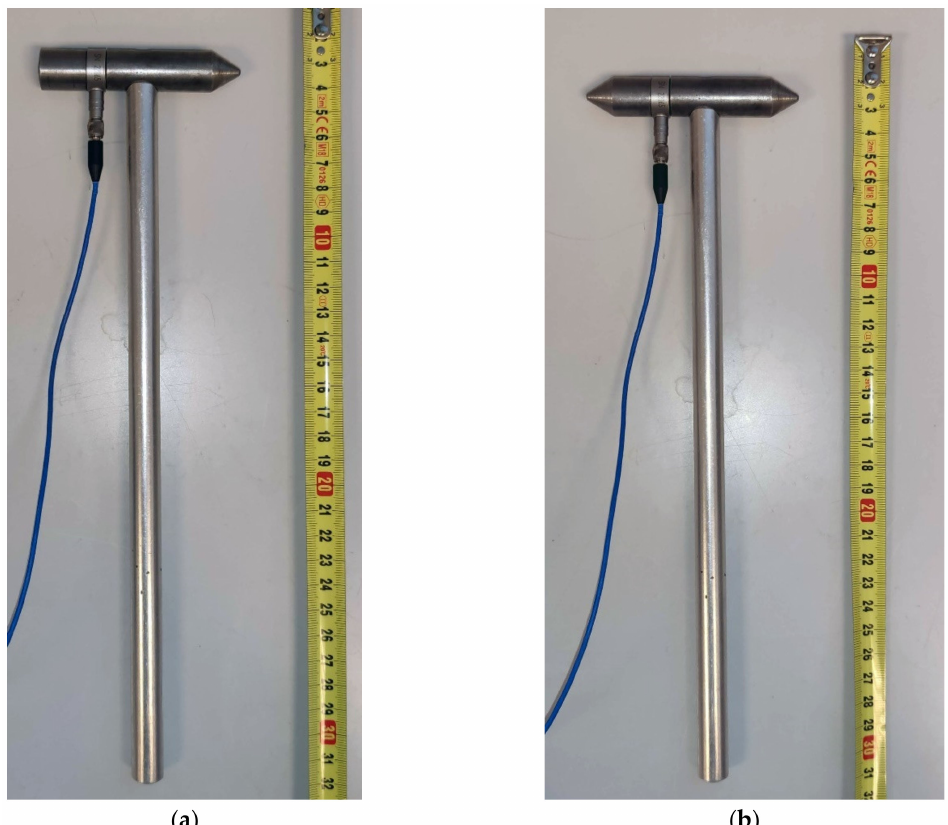
Figure 8. Hammer with a handle: ( a ) With a blunt tip; ( b ) with a sharp tip.